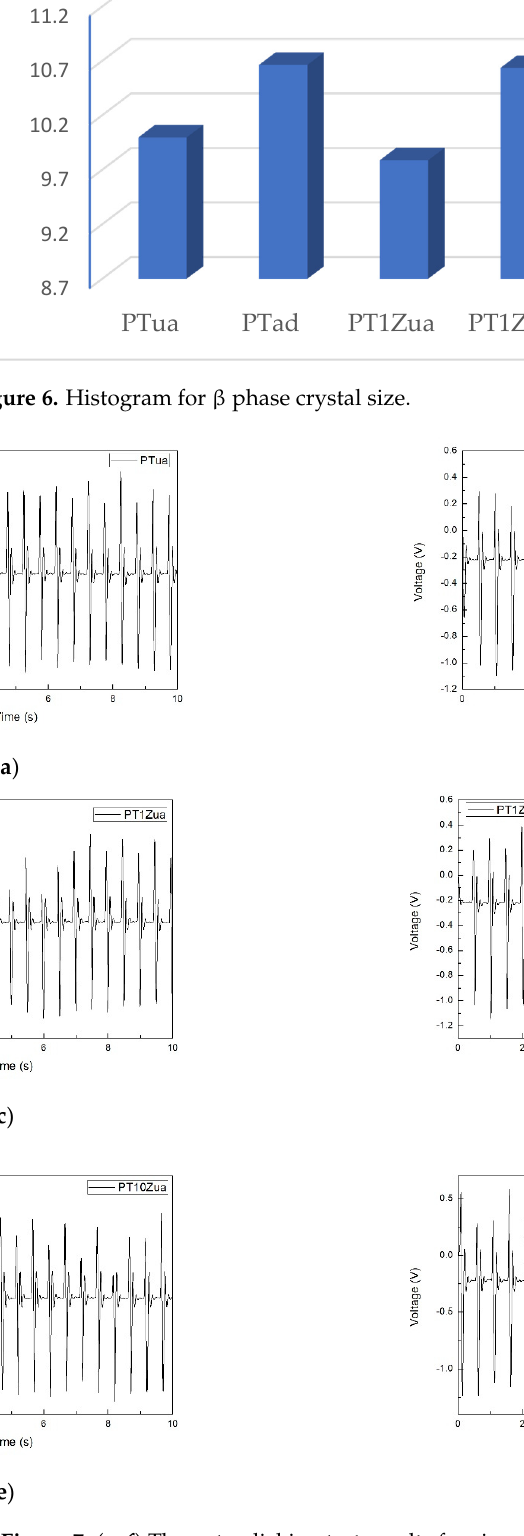
Figure 6. Histogram for β phase crystal size.